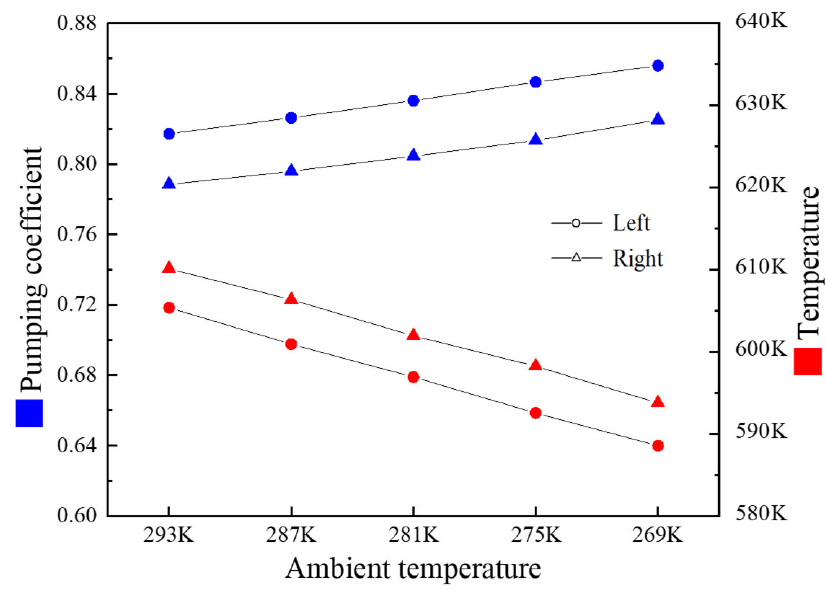
Figure 9. Pumping coe ffi cient and average exhaust temperature of the mixing duct.